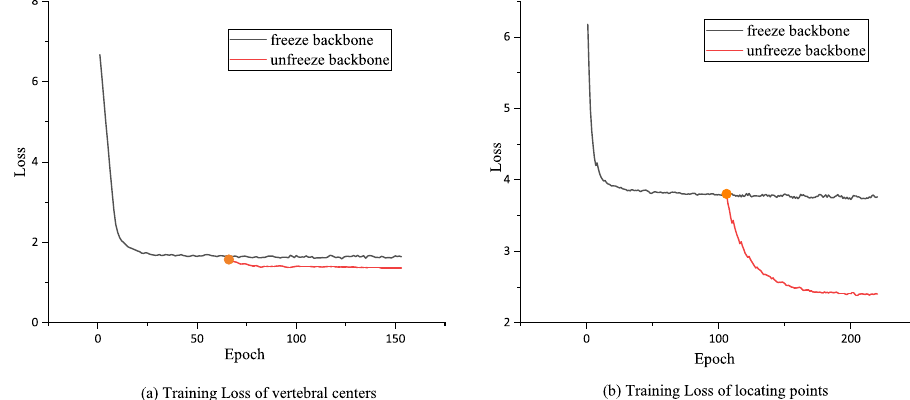
Figure 4. Training